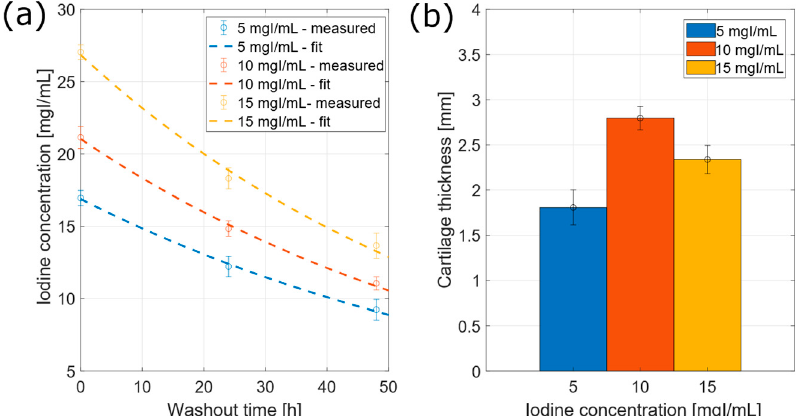
Figure 7. Results following PBS washout of bovine tibiae. ( a ) Washout curve of CA4+ from cartilage to PBS bath, for different concentrations, pointing out the iodine concentration retained in cartilage with respect to washout time. ( b ) Cartilage thickness reported for each tibia, after 24-h bath in CA4+ solution at different iodine concentration.